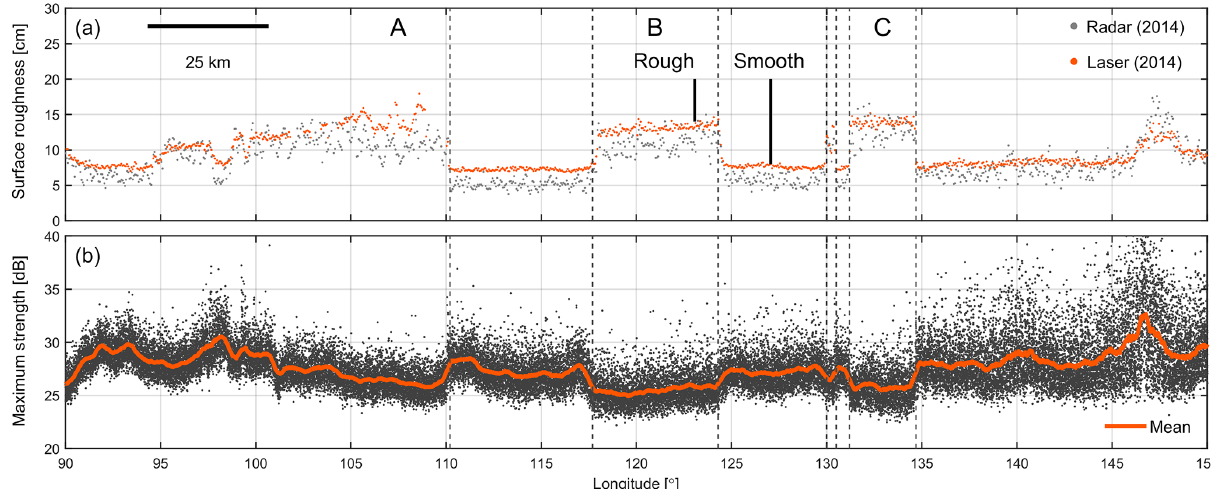
Figure 9. (a) Surface roughness from 2014 ATM laser and CReSIS Ku-band radar data over roughness features “A”, “B”, and “C” (Fig. 4b). Vertical black lines mark the locations of radar waveforms over smooth and rough surfaces shown in Fig. A4. (b) Maximum of relative return signal strength from 2014 snow radar data. The red line is a running mean calculated over 350 radar traces ( ∼ 2km), which is similar in size to the 1.65km CryoSat-2 footprint in low-resolution mode (LRM) over smooth surfaces (Scagliola, 2013). The strength of the surface return is around 3dB weaker over rough areas compared to smooth